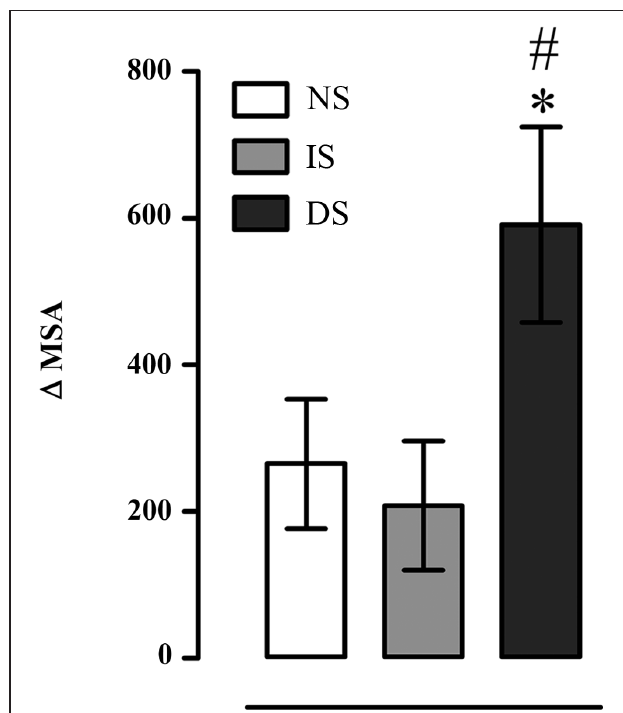
FIGURE 5 | Difference in mean startle amplitude between moments with presence and absence of pulse ( (cid:2) MSA); NS = no-shock group ( n = 10); IS = immediate shock group ( n = 10); DS = delayed shock group ( n = 10). * p < 0.05 compared to NS group; # p < 0.05 compared to IS